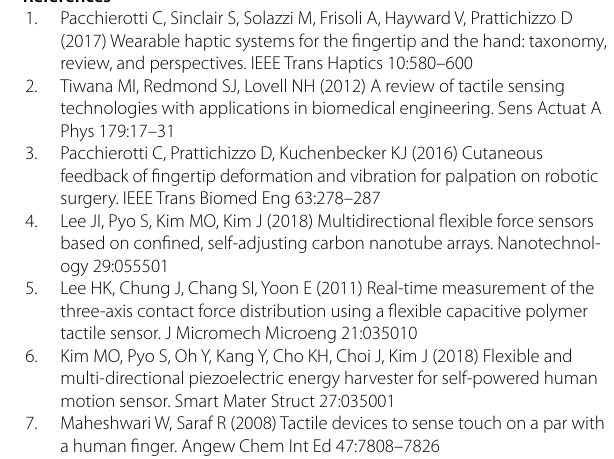
Fig. 7 Changes in resistance of the piezoresistors against applied a normal and b shear forces. The resistance of E 3 decreases as the applied normal force increases, with a slope of mN ‒ 1 for force ranges of 0 ‒ 300 and 300 ‒ 500 mN, respectively. When a shear force in the x‑direction is applied, the resistance of E 1 increases with a slope of 1.2 Ω mN ‒ 1 , while that of E 3 decreases with a slope of 1.2 Ω mN ‒ −